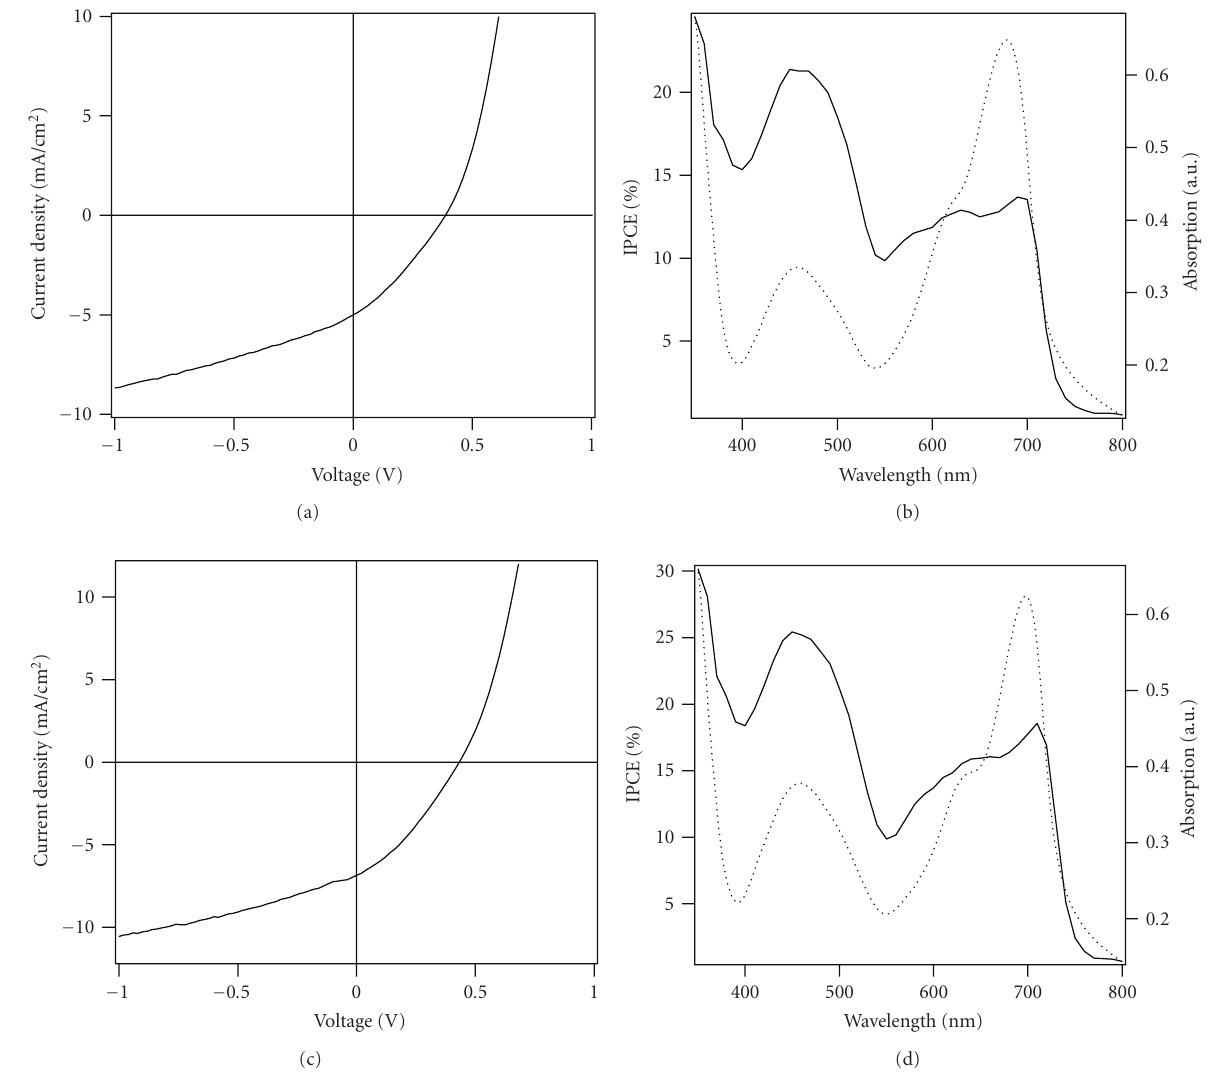
Figure 4: Current-voltage characteristics and IPCE curves for solar cells based on 20 nm thick SQ01 ((a) and (b)) and SQ02 ((c) and (d)) films. The dotted lines in (b) and (d) represent the absorption of SQ01 and SQ02 based cells,